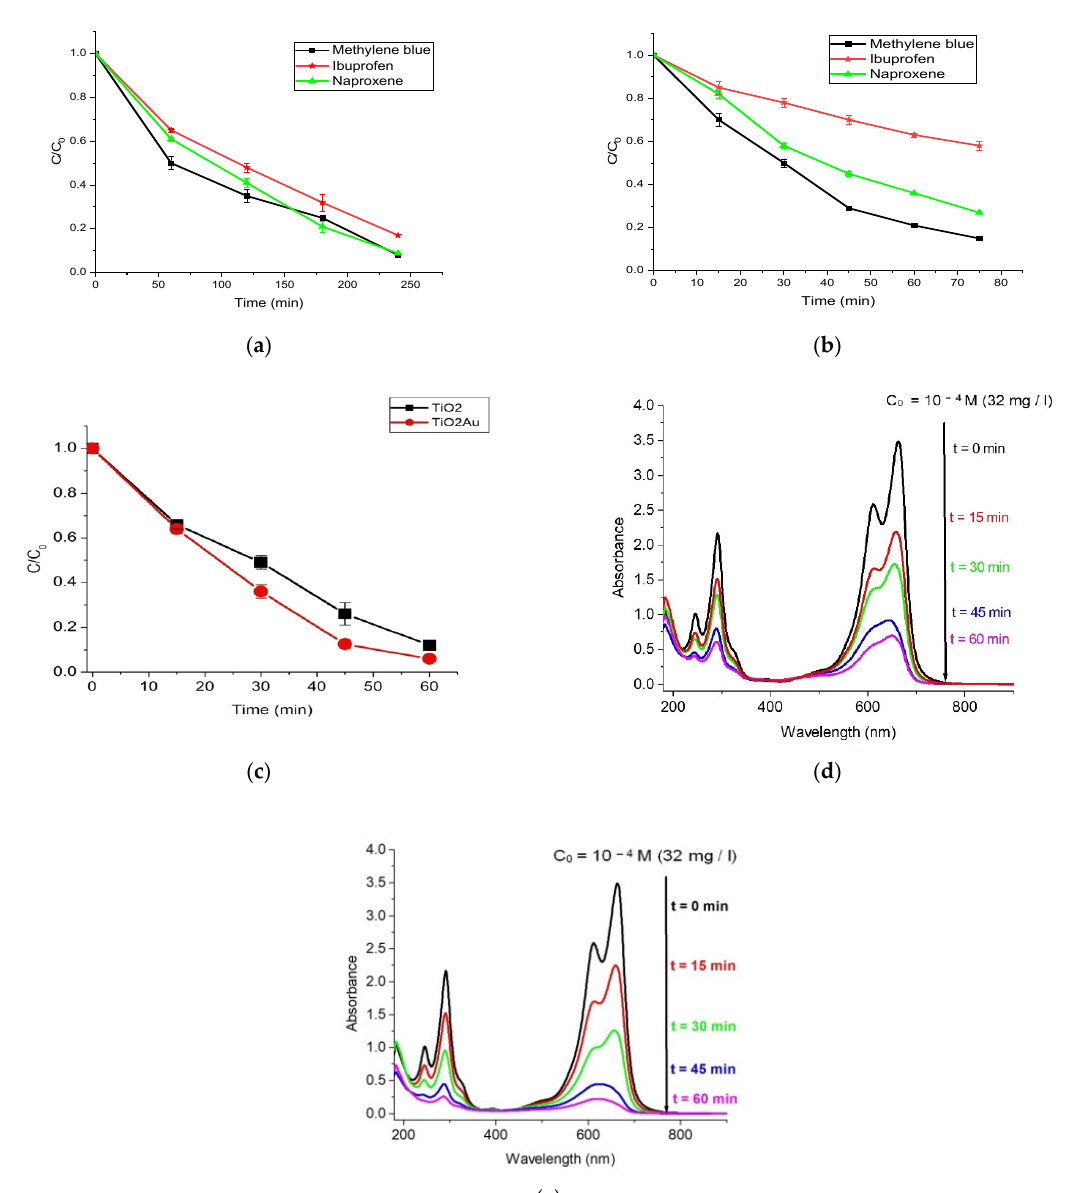
Figure 8. Photocatalytic degradation of methylene blue (MB) dye, ibuprofen, and naproxen for ( a ) cycle 1 and ( b ) cycle 2 under direct solar irradiation; ( c ) degradation of MB under controlled visible light irradiation; and UV–visible spectra of ( d ) TiO 2 and ( e ) Au/TiO 2 NCs for MB degradation.